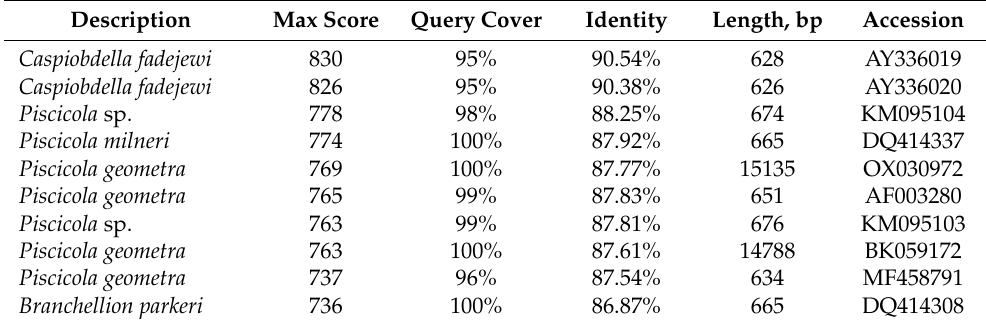
Table 2. Top 10 Homologous Piscicolidae sequences selected by BLAST, with the statistical signifi- cance of the